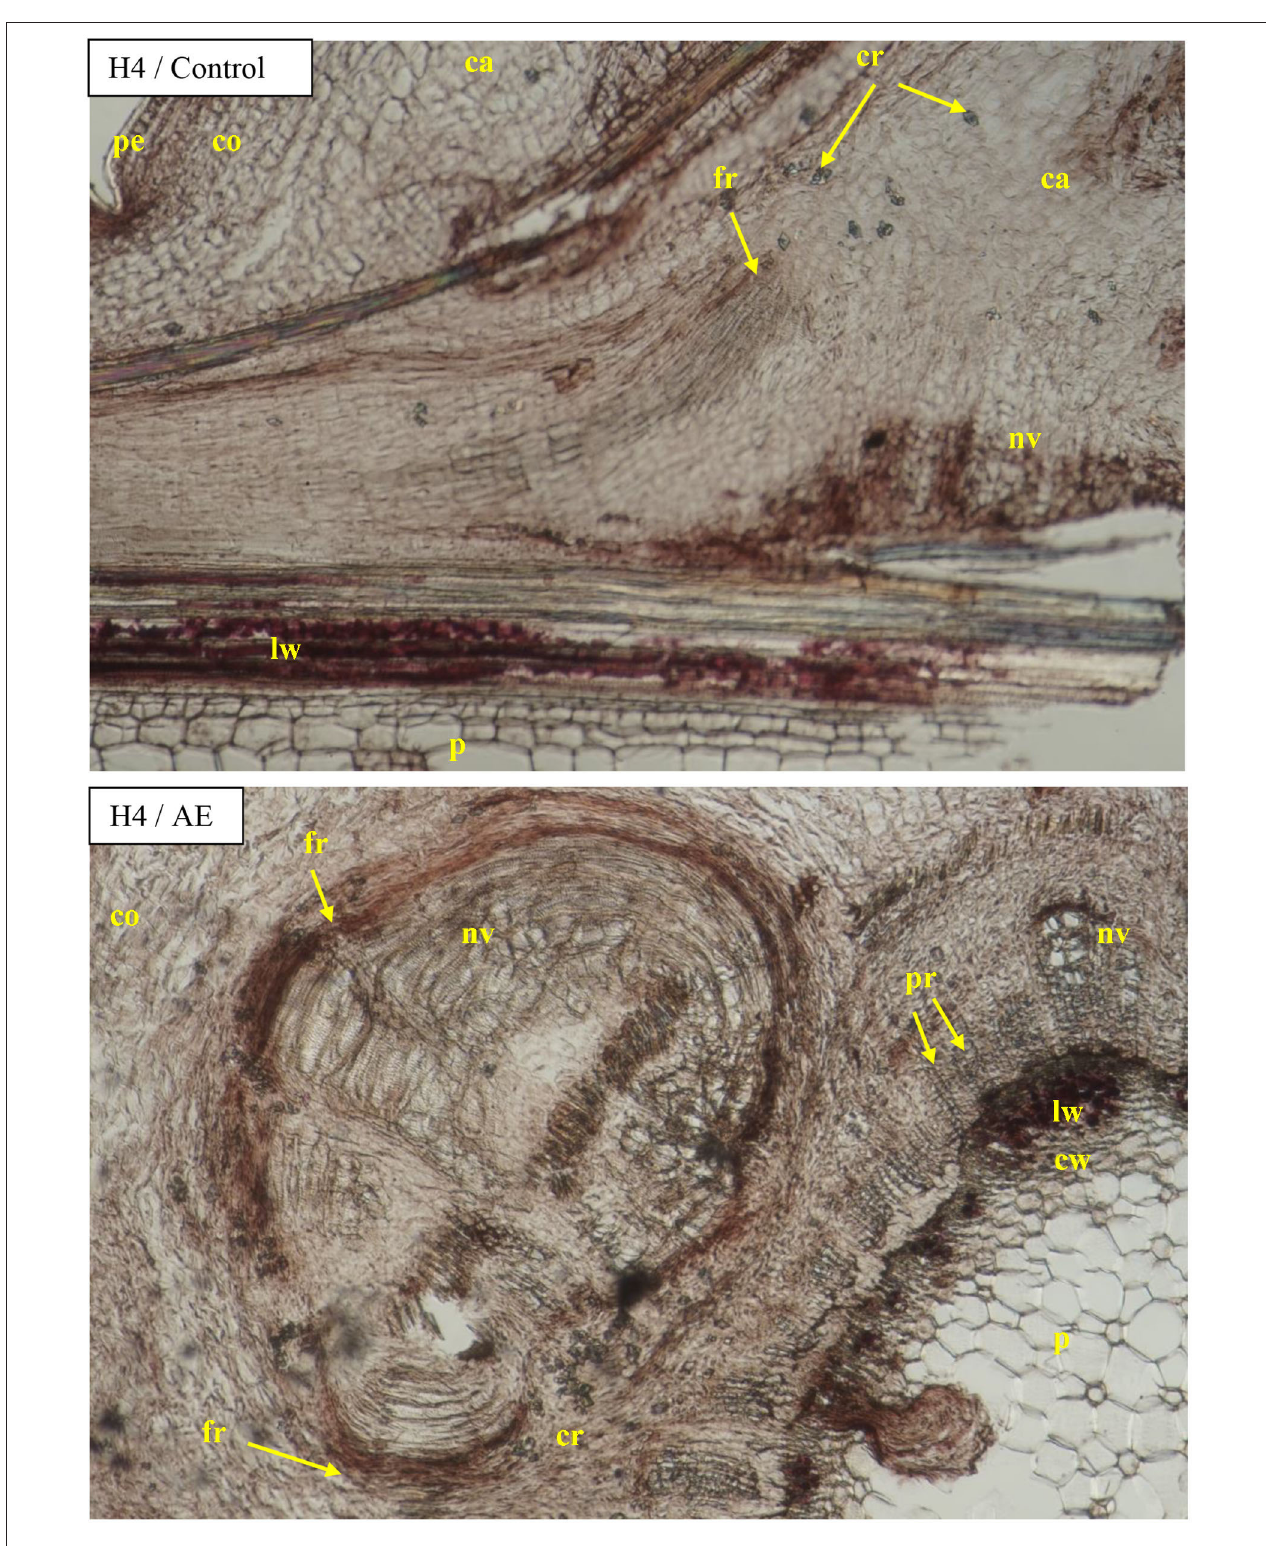
FIGURE 9 | Transverse and longitudinal sections of the shoots after 25 days of the process of rhizogenesis rooting in Rosa “Hurdal” in the phenological stage in BBCH scale (Meier et al., 2009) H4 − 70 701 [fruit set: beginning of hip (berry) growth on the main stem] in control cutting and after treatment of AE—Algae extract—watering with 0.6% Bio Rhizotonic (10ml) after planting, 10 and 20 days later. Designation of signs: pe, periderm; ca, callus; co, cortex; cr, crystals; p, pith; pr, pith rays; nv, new vessels/vascular bundles; ew, earlywood; lw, latewood; fr, forming root.